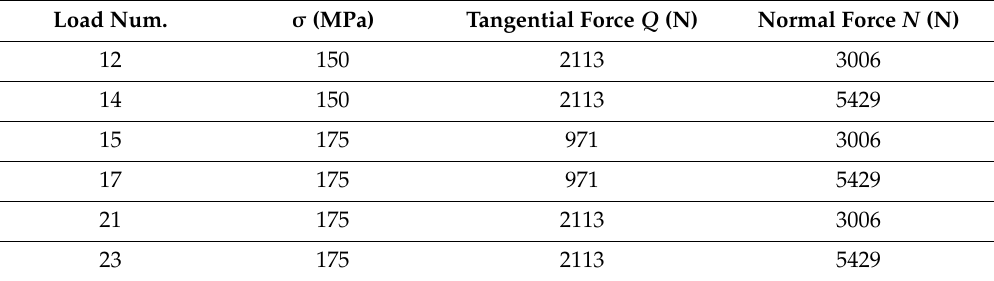
Table 7. Fretting load combinations used to measure cyclic relaxation of residual stress. Load